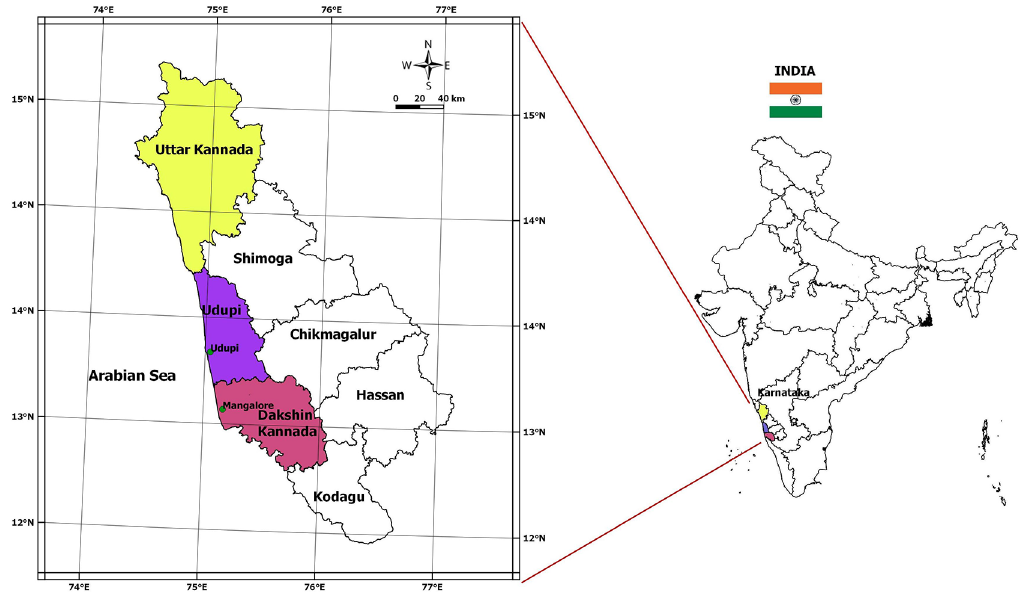
Figure 1. Location map of study